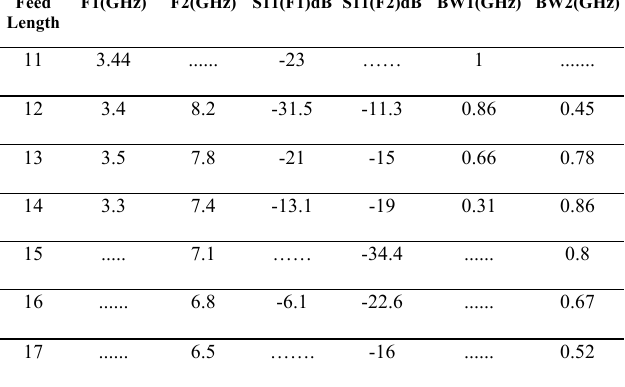
Table1: Electrical specification with respect to feed line length